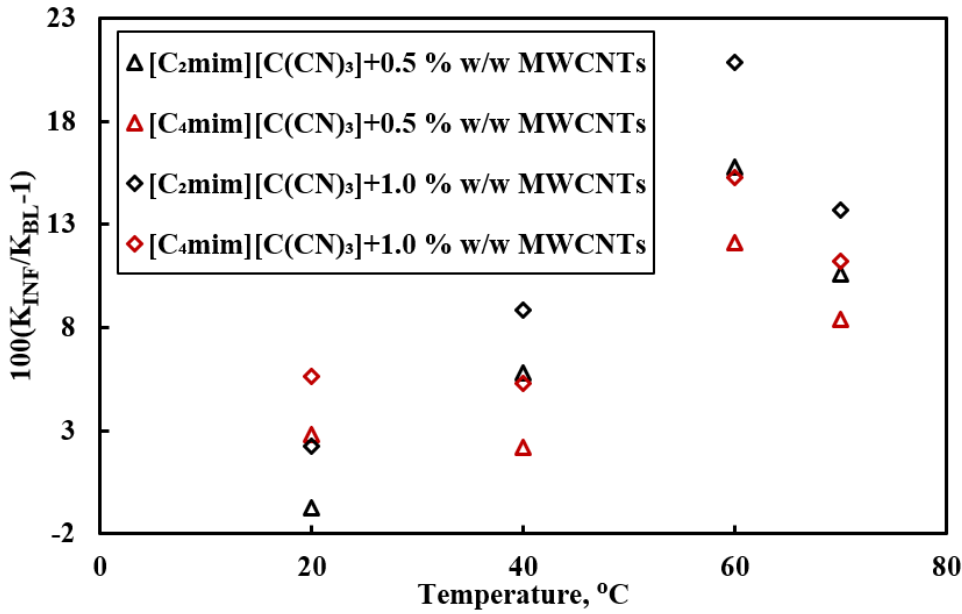
Figure 14. Enhancement ratio of the thermal conductivity of MWCNTs-enhanced ILs as a function of nanoparticle concentration and temperature with C(CN) 3 anion [63]. Reproduced with permission from [França], [Ind. Eng. Chem. Res.]; published by [ACS], 2018.